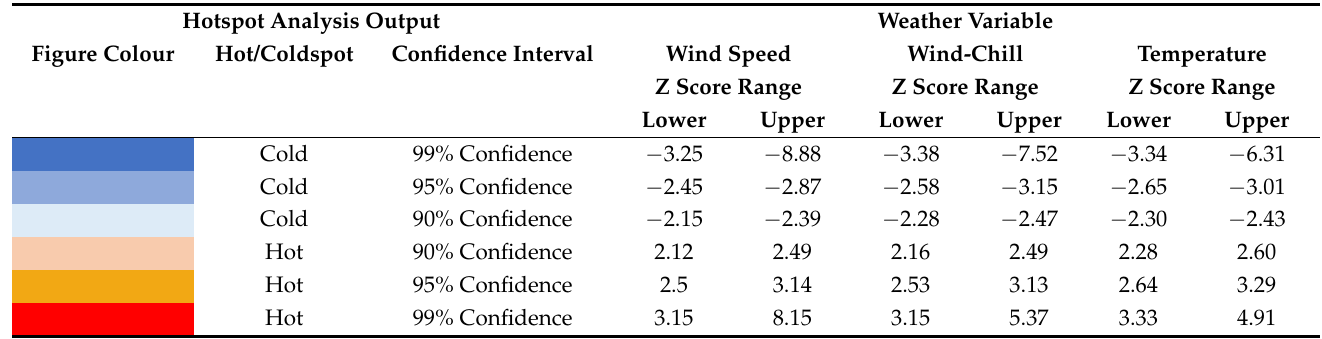
Table 5. Z scores relating to the significant hot and coldspots from the Getis-Ord Gi* Analysis (Figure 3).